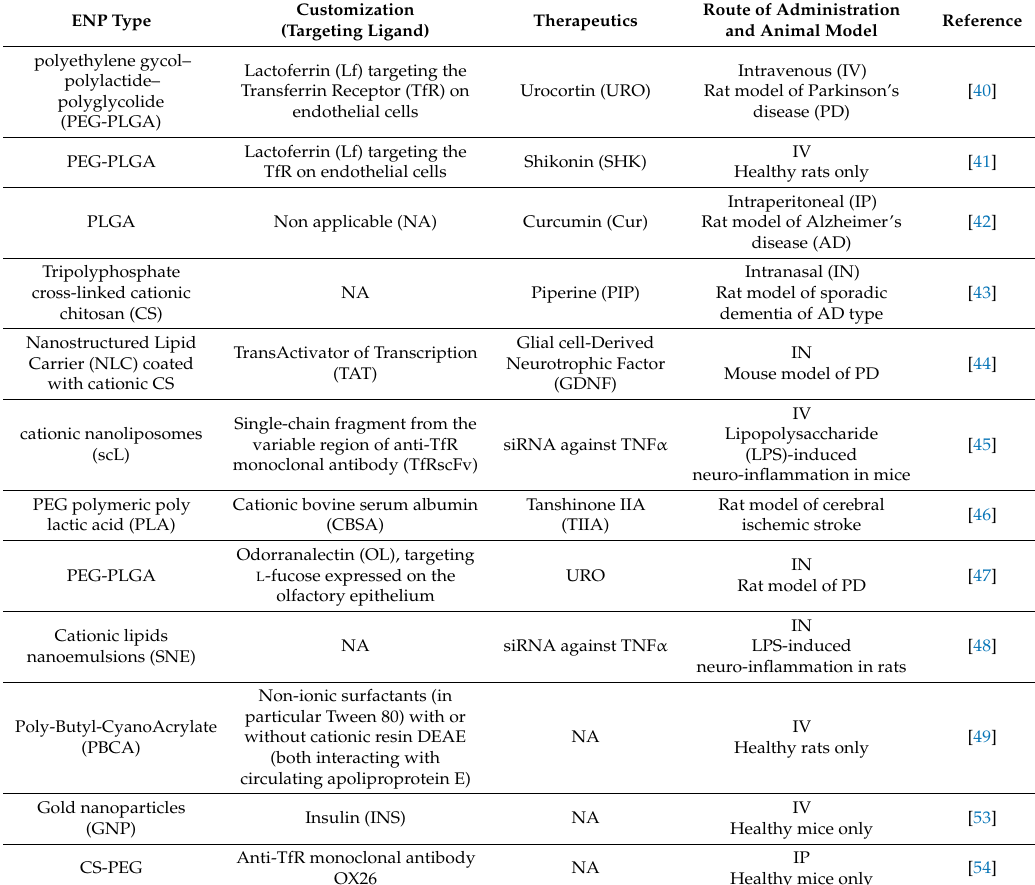
Table 1. Compilation of the studies selected for the current